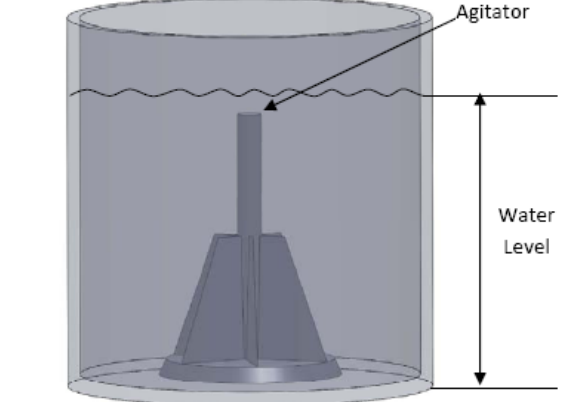
Figure 1. Horizontal and vertical axis washing machine